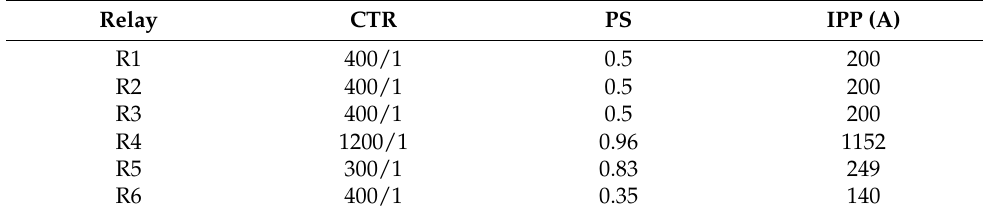
Figure 4. The benchmark IEC microgrid. Table 2. The OCR parameters (CTR, PS, and IPP) in the proposed